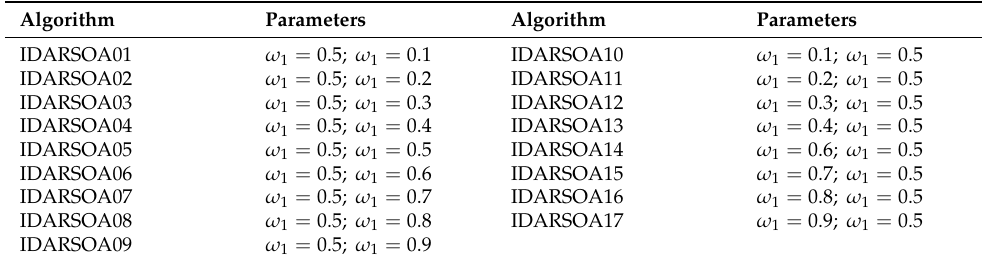
Table 2. Parameter settings of IDARSOA.